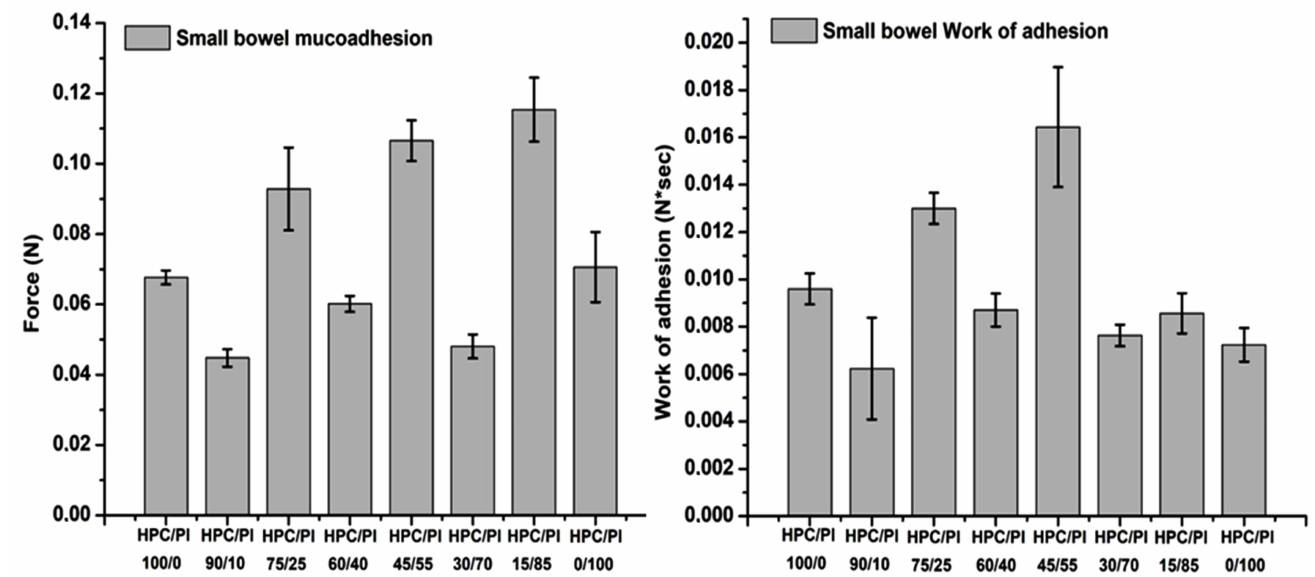
Figure 13. Mucoadhesion evaluation of the studied blend